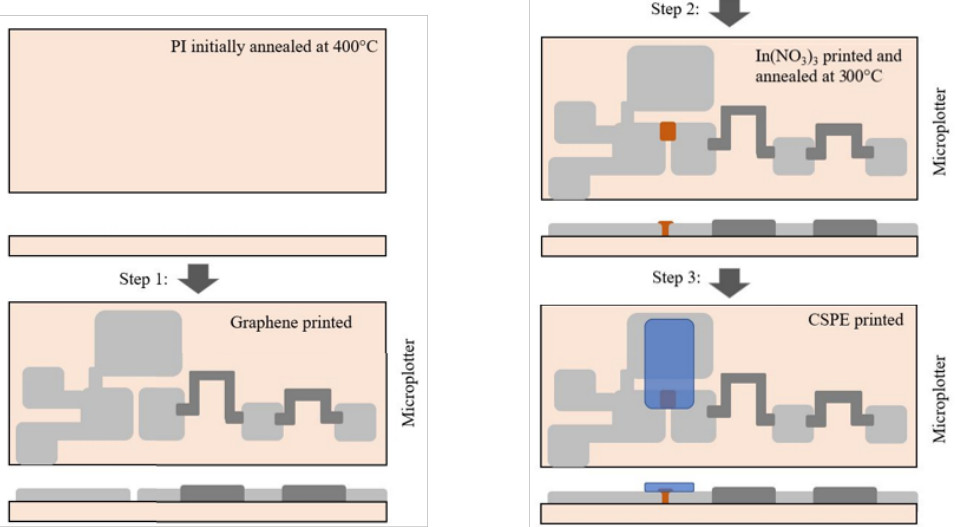
Figure 5. Neuron fabrication steps using the printing equipment described in Section 2. For each step, the top and side views of the printed structure are provided. Polyimide was preheated to 400 °C. In Step 1, graphene of varied thickness was printed, reflected in magnitude of resistance